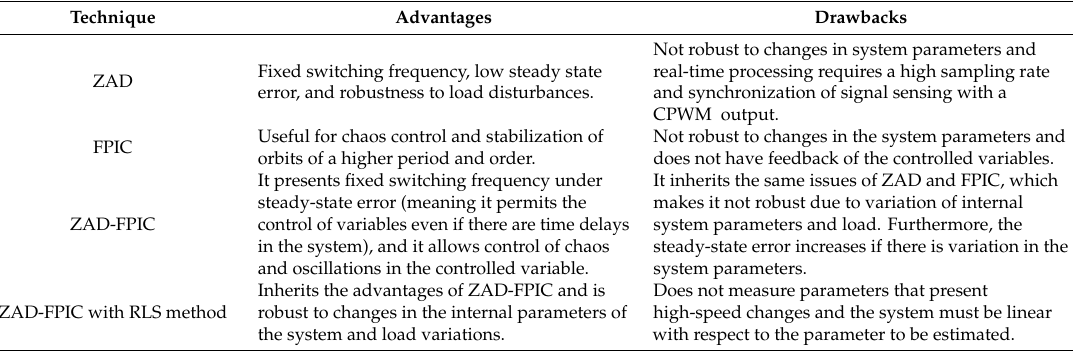
Table 1. Advantages and drawbacks of the ZAD and FPIC